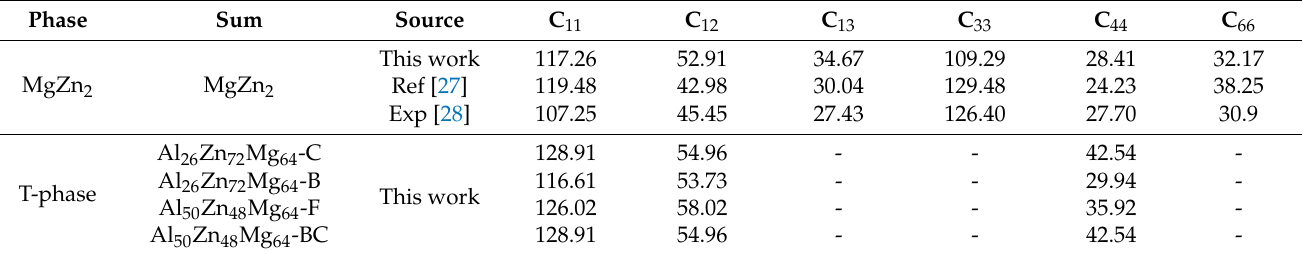
Table 3. Calculated elastic constants of phases MgZn 2 and T phase, C ij